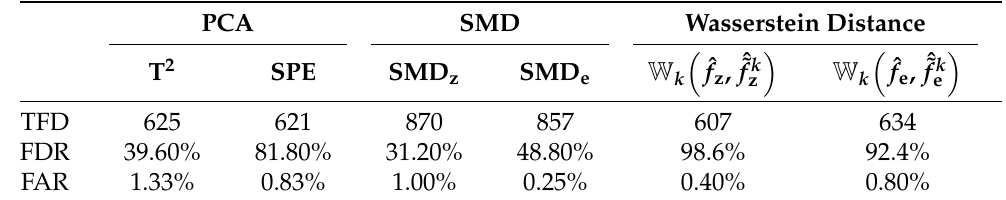
Table 5. Comparison of fault detection performance on boiler water wall over-temperature process